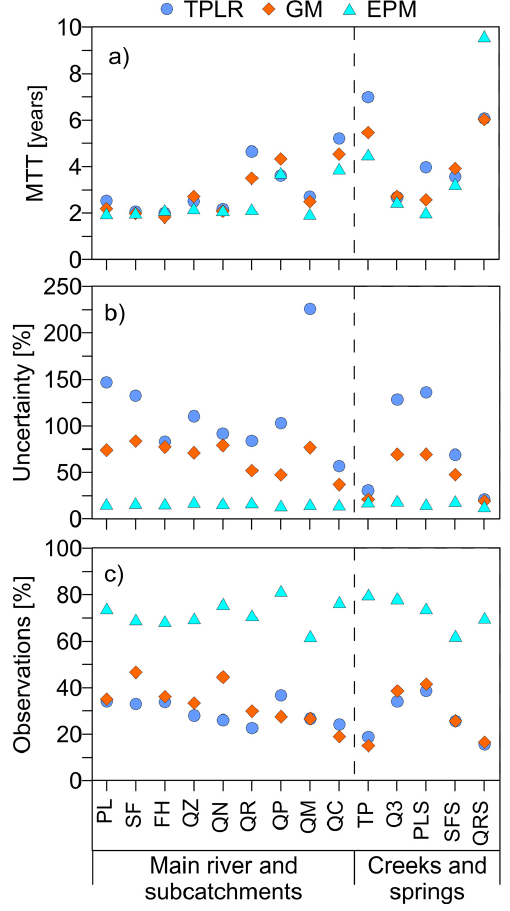
Fig. 10. Intercomparison of models for surface waters and springs according to their (a) estimated mean transit times; (b) uncer- tainty ranges expressed in percentage of its respective MTT estima- tion; and (c) number of observations inside the range of behavioral